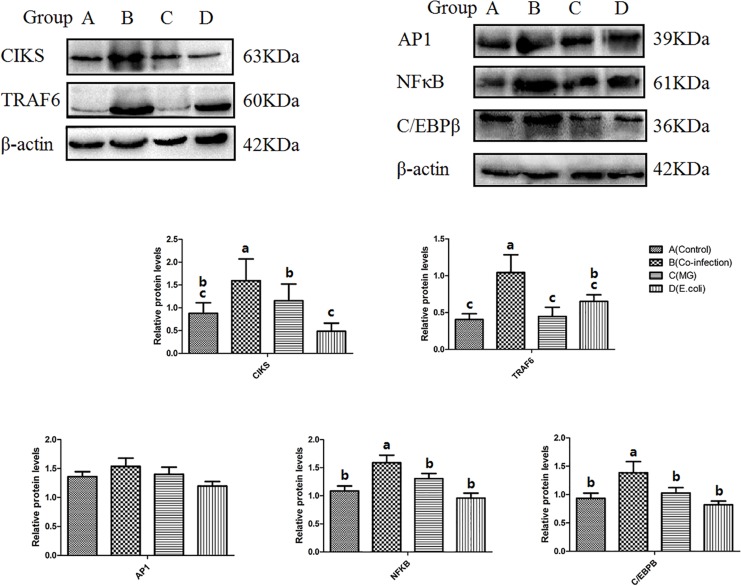
Protein levels of CIKS, TRAF6, NFκB, AP1, and C/EBPβ as measured by Western blot. β-actin was used as a control. Bars represent the mean ± SD. Bars with different superscript letters are significantly different (0.01 < P < 0.05).